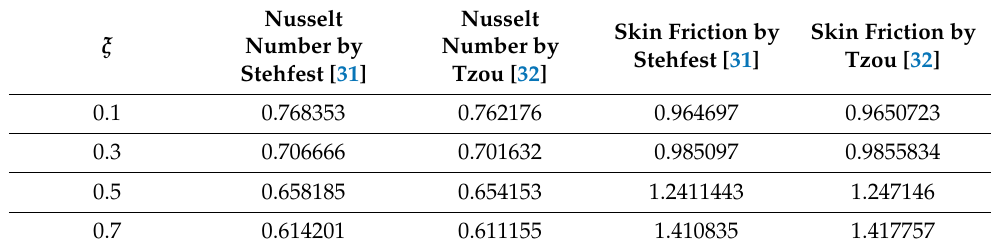
Table 3. Numerical analysis for Nusselt number and skin friction by both numerical algorithms. Nusselt Number ξ